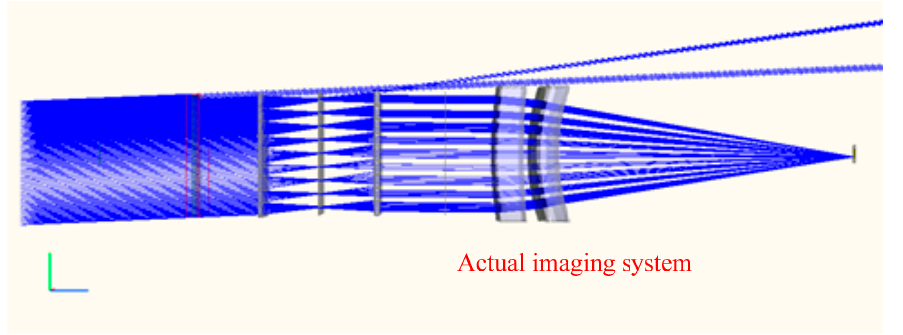
Figure 12. Schematic diagram of optical system with actual imaging system (Y axis, δ = − 2°, θ = − 0.5°).